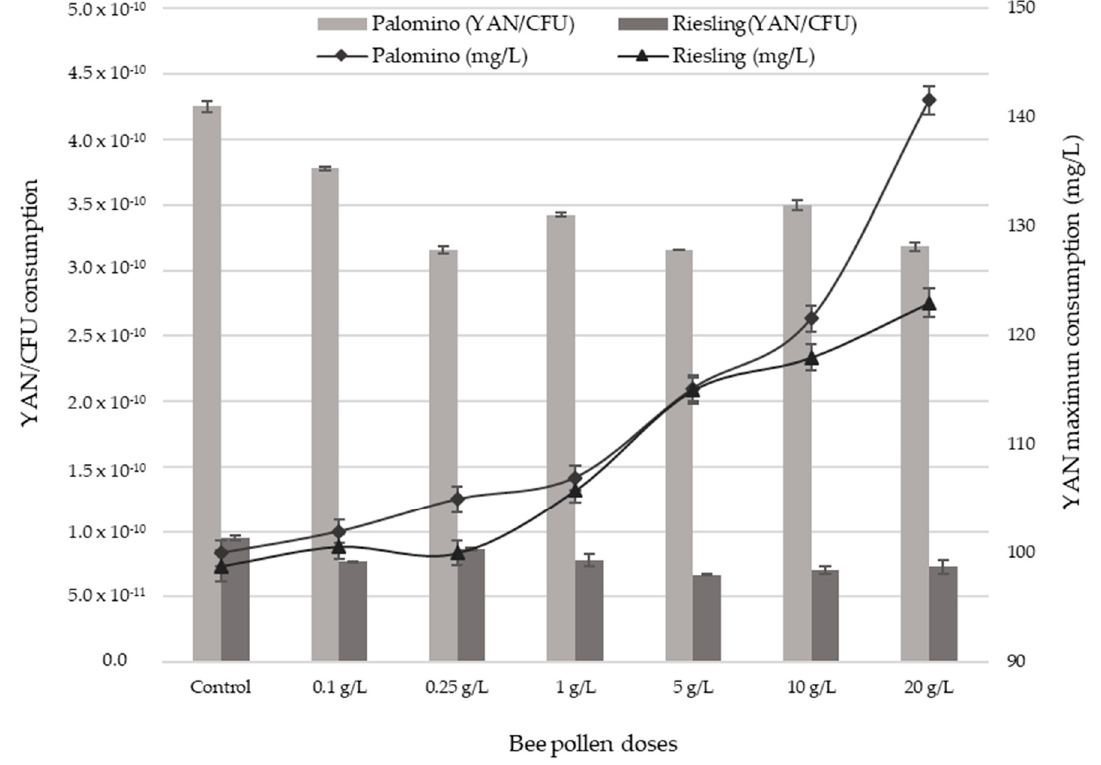
Figure 6. Maximum consumption of YAN against the maximum consumption of YAN/CFU during exponential growth phase of Palomino fino and Riesling grape musts with different bee pollen doses and control.